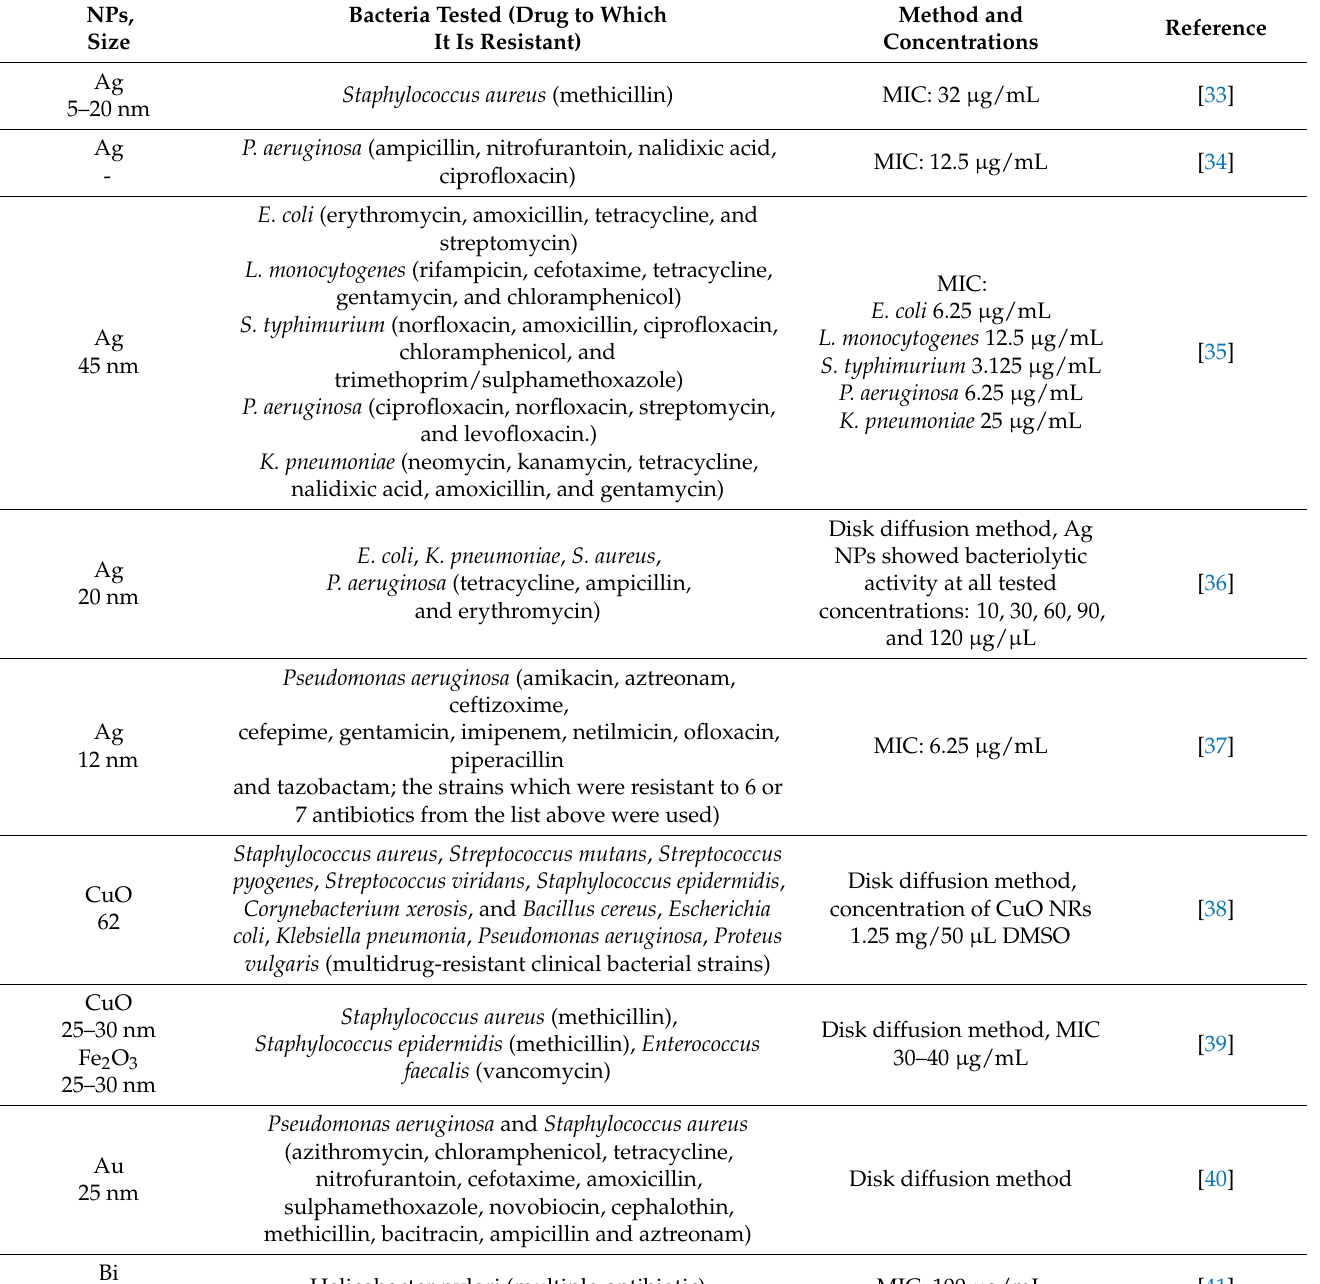
Table 1. Research addressing the use of INPs against drug-resistant